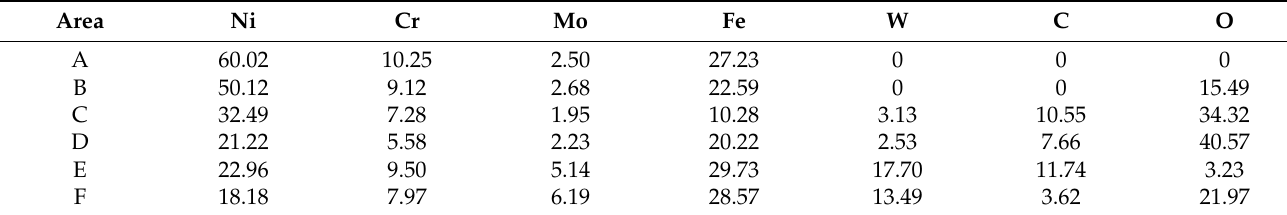
Table 6. EDS of the friction zone of the coatings